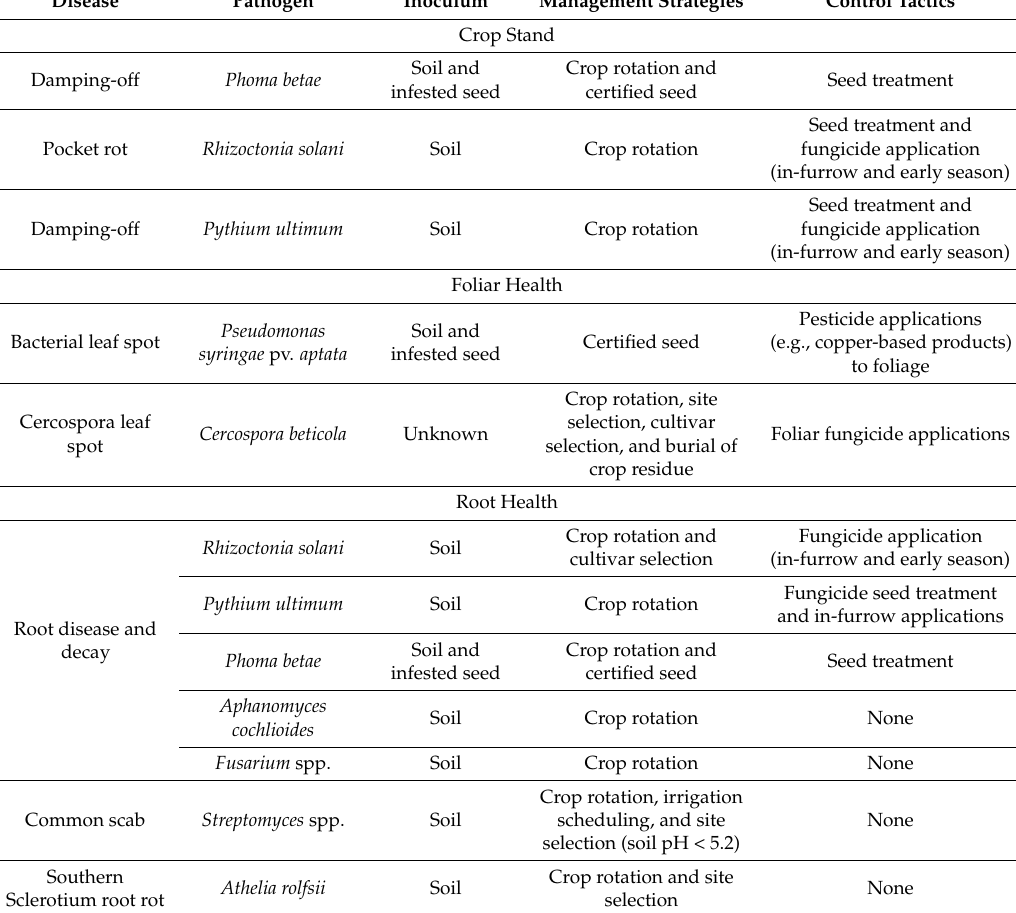
Table 1. Diseases affecting table beet production in New York including dominant current management strategies and control